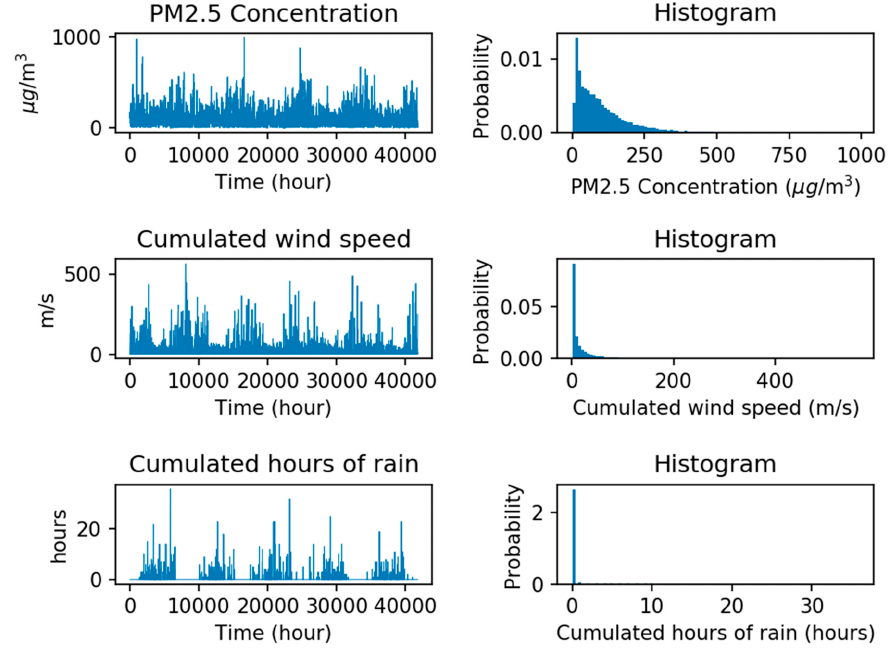
Figure 7. Beijing PM 2.5 dataset.